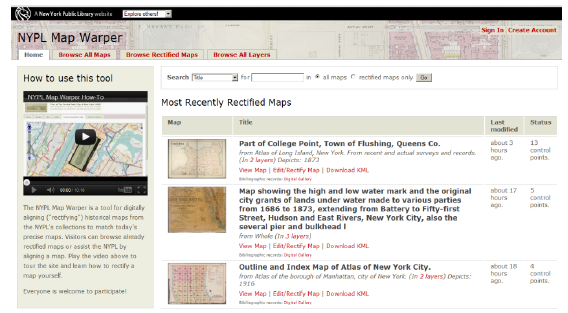
Figure 8: New York Public Library’s Map Rectifier Project [http://maps.nypl.org/warper/] (C) Combating illicit trafficking of antiquities.